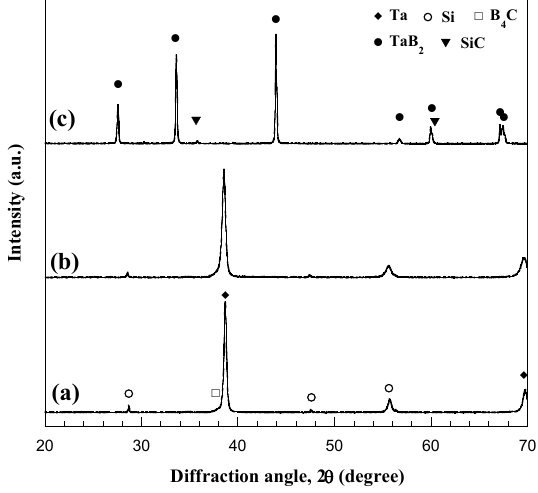
Figure 9. XRD analysis results during the synthesis of TaB ( a ) original reactants; ( b ) ball milled reactants and ( c ) products. Adapted from